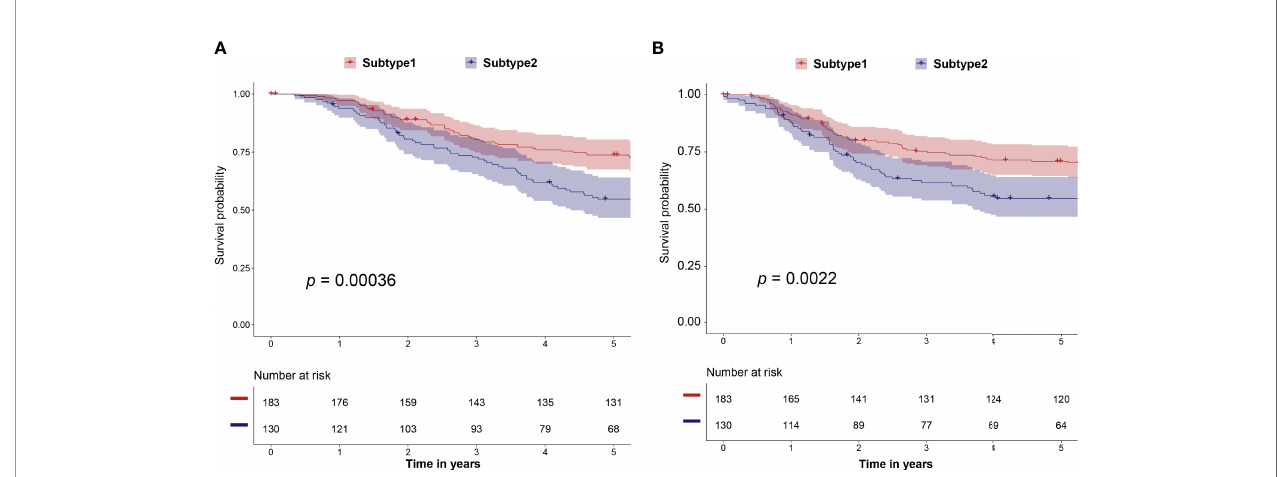
FIGURE 7 | The correlation of predicted immune subtype with the prognosis in the independent dataset (METABRIC dataset). (A) Five-year Kaplan – Meier curves for OS of TNBC patients strati fi ed by the immune subtypes. (B) Five-year Kaplan – Meier curves for RFS of TNBC patients strati fi ed by the immune subtypes. The p -values were calculated by the log-rank test among subtypes. METABRIC, Molecular Taxonomy of Breast Cancer International Consortium; OS, overall survival; RFS, relapse-free survival.